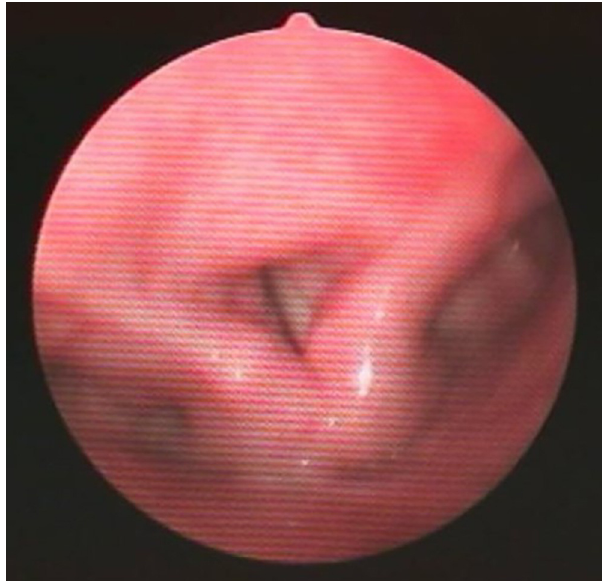
Figure 1 The endoscopy executed during sleep evidences the paradoxical movement of adduction during inspiration.